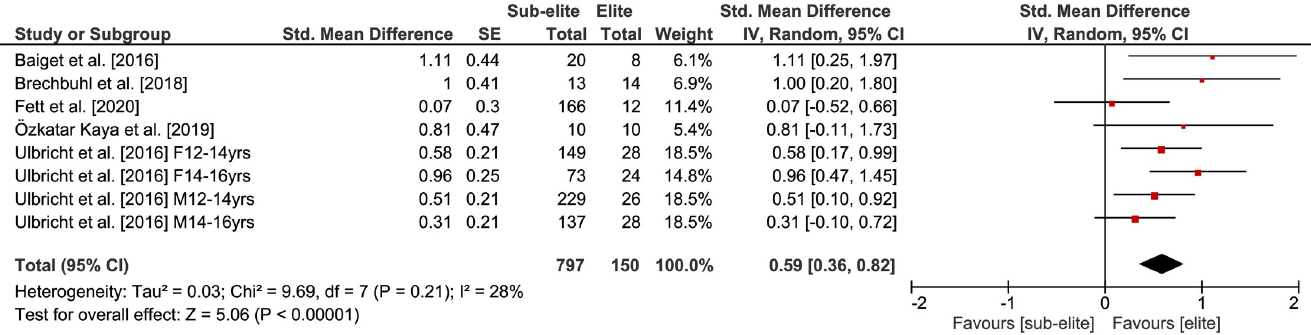
PLOS ONE | https://doi.org/10.1371/journal.pone.0269516 June 3,